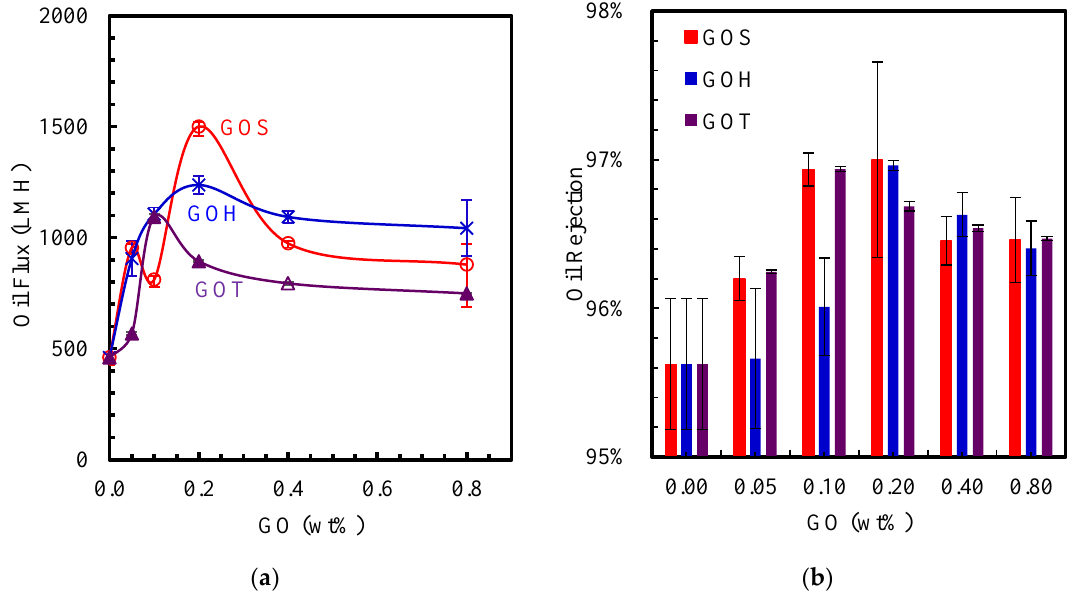
Figure 7. Oil-emulsion flux at 2 bar ( a ) and oil rejection ( b ) of PSf-GO modified membranes.